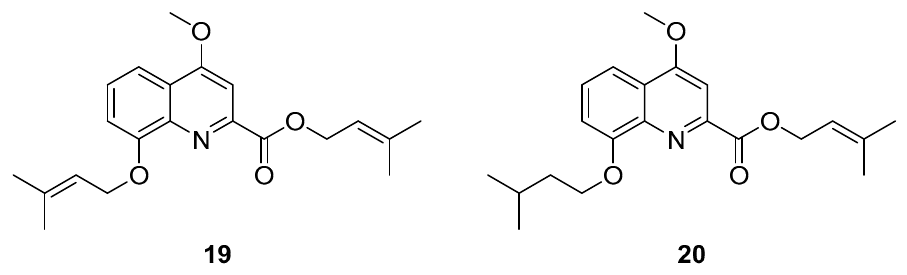
Figure 13. Ppc-1 ( 19 ) and PQA-11 ( 20